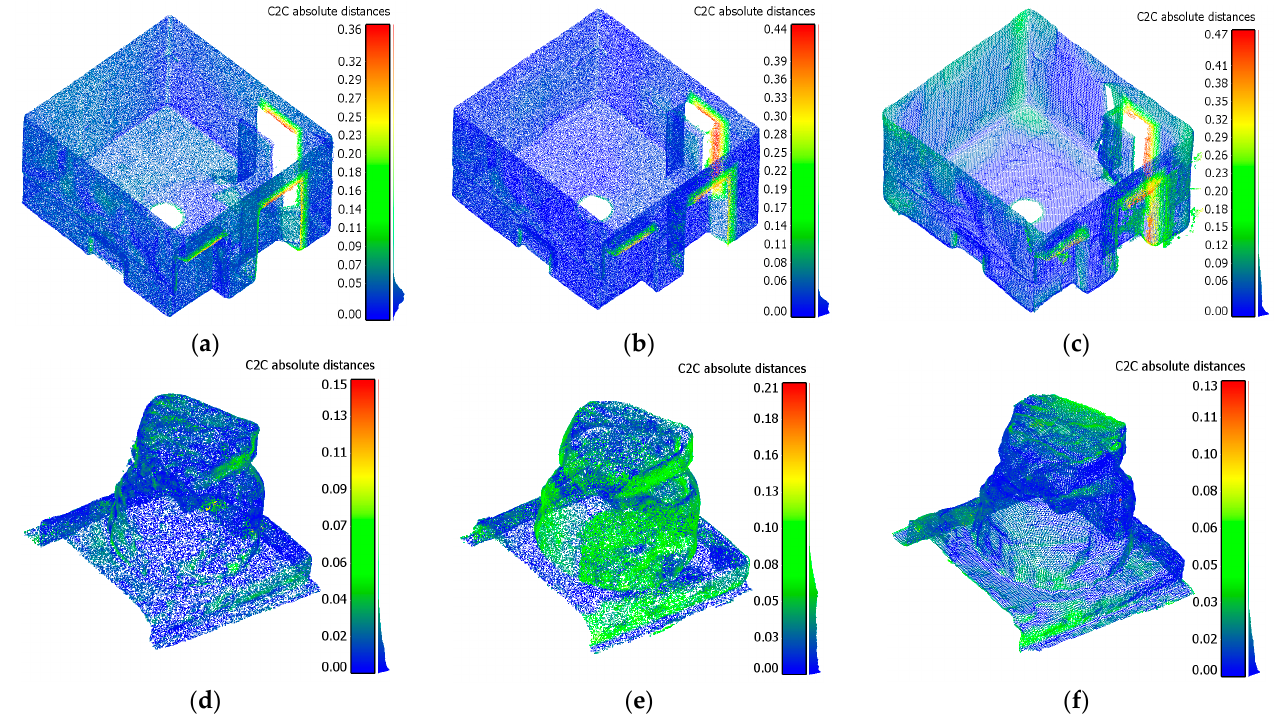
Figure A5. Sections of the point clouds of the stem of the statue; the scalar field refers to the surface variation value: 1.5 cm resolution scan performed at 2 m ( a ), 2 cm resolution scan performed at 2 m ( b ). Figure A6 shows the histograms of the calculated C2C distance for the third and fourth case studies. Figure A6a shows the histogram of the laboratory room scanned with 1 cm resolution; Figure A6b shows the histogram of the laboratory room scanned with 1.5 cm resolution; Figure A6c shows the histogram of the laboratory room scanned with 2 cm resolution. Figure A6d shows the histogram of the Doric column rests scanned at 1 cm resolution, Figure A6e shows the histogram of the Doric column rests scanned at 1.5 cm resolution, and Figure A6f shows the histogram of the Doric column rests scanned at 2 cm resolution.